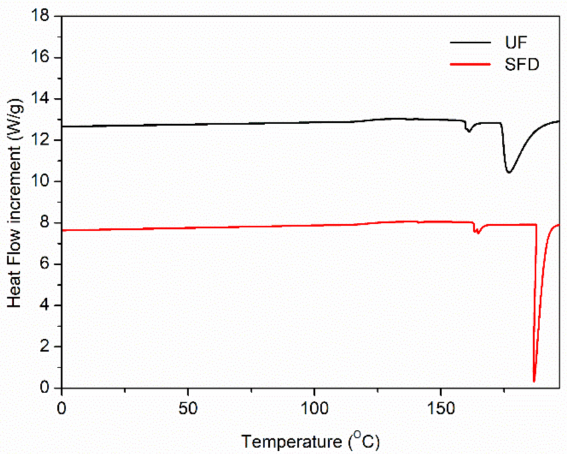
Figure 3. DSC thermograms for the UF and SFD porcine plasma protein systems run at a heating rate of 10 ◦